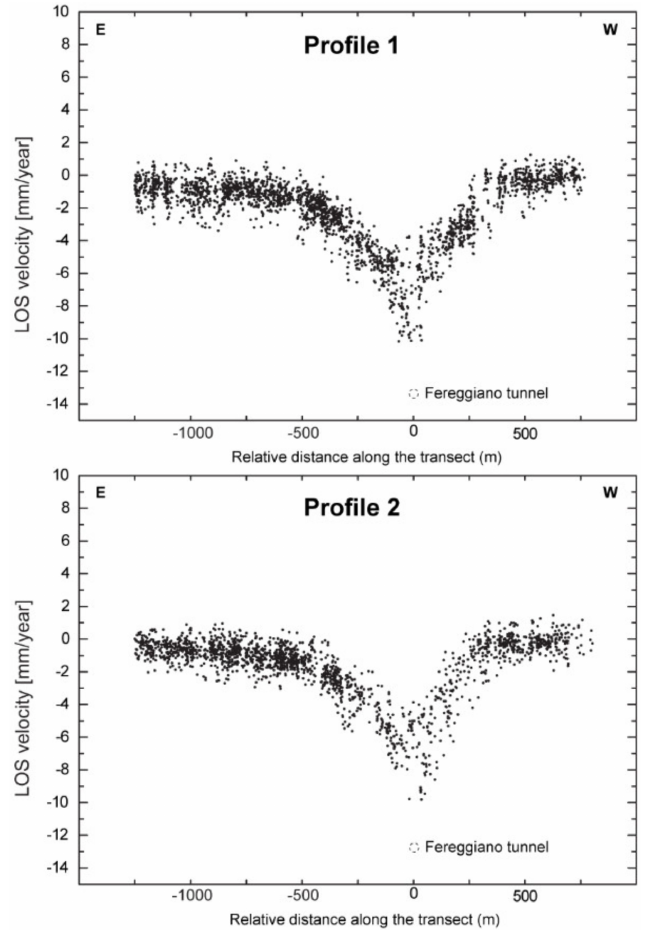
Figure 6. Subsidence trend profiles of the settlements area. The vertical axis displays the settlement velocity in mm/y. The horizontal axis is expressed in meters and indicate the relative distance from the tunnel along the